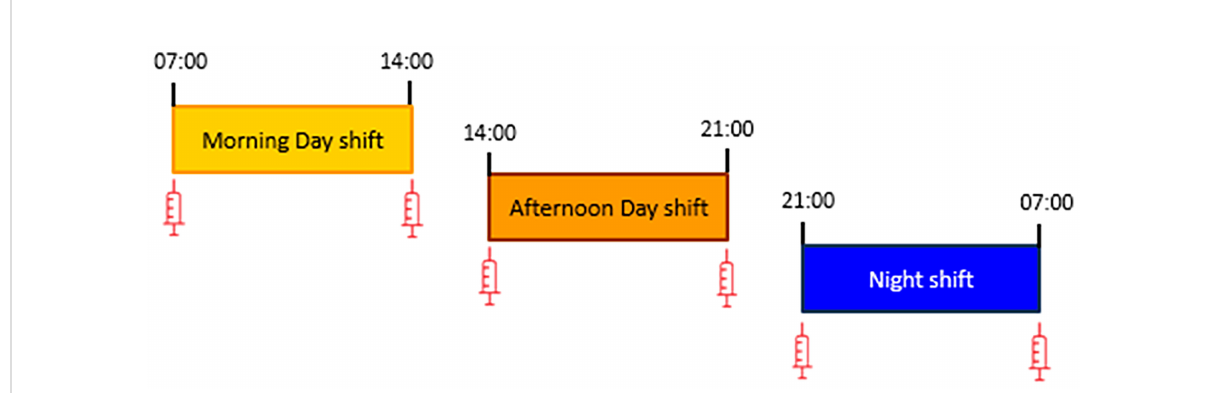
FIGURE 1 Schedules for blood sampling at the beginning and end of the work shift for morning (7:00 and 14:00), afternoon (14:00 and 21:00) and night (21:00 and 7:00)